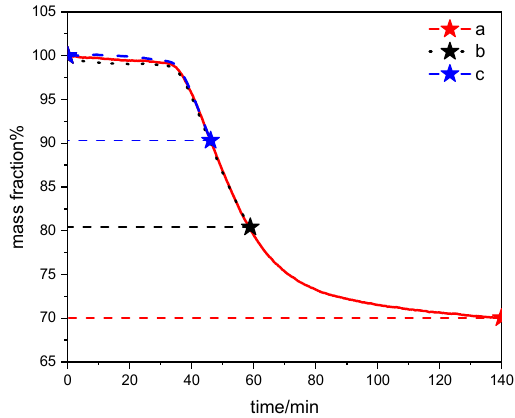
Figure 1. The thermal mass loss of AP at 230 °C.